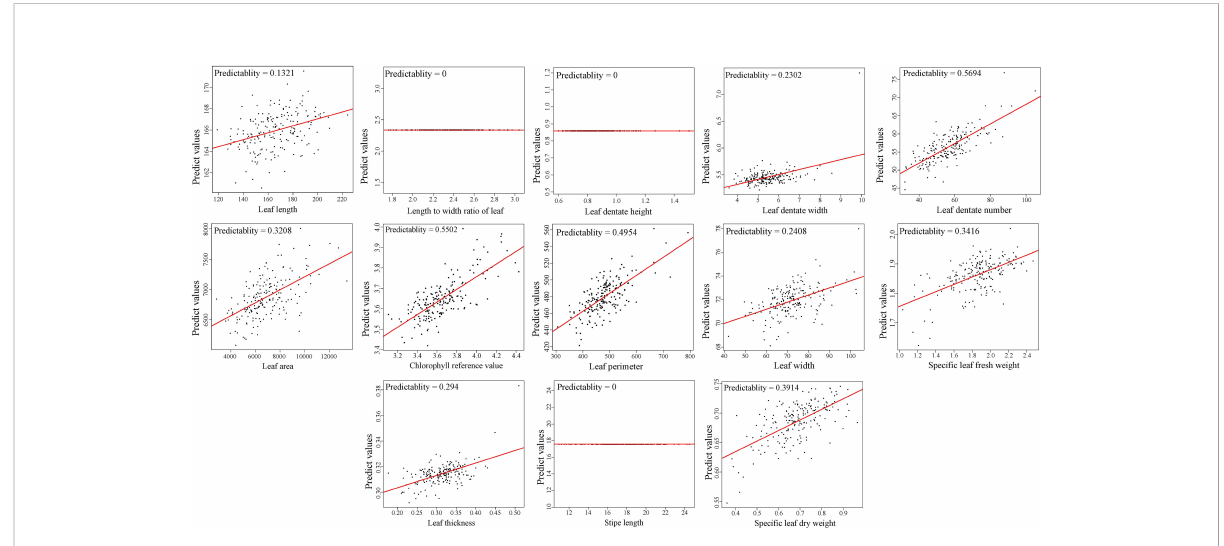
FIGURE 5 Average predictability of the 13 morphological traits by LASSO